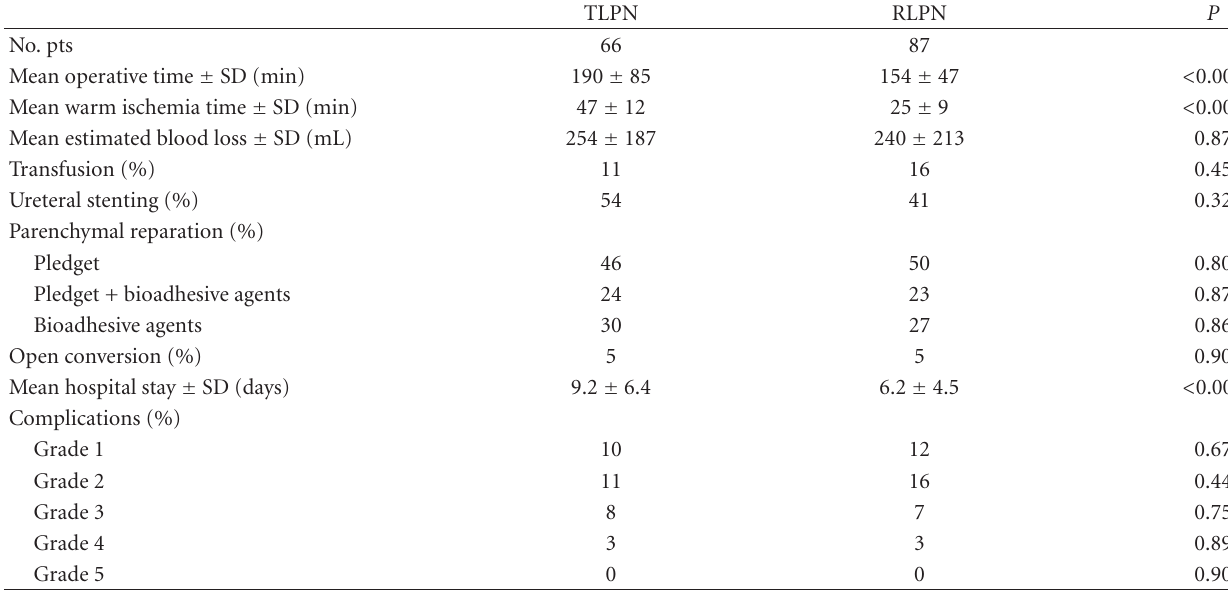
Table 2: Perioperative data and